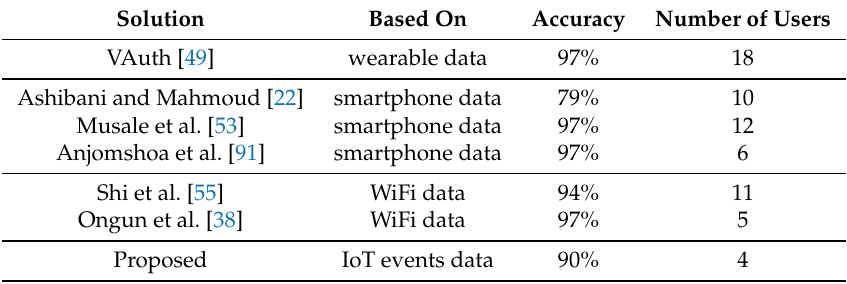
Table 7. Accuracy comparison with continuous authentication solutions found in the literature. Solution Based